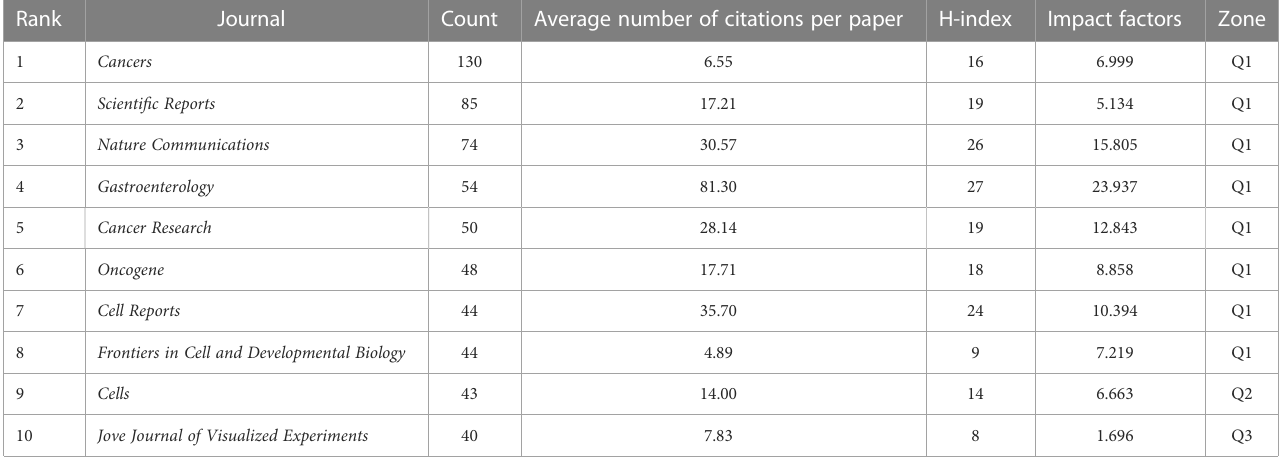
TABLE 5 The top ten journals that published papers on tumor organoid